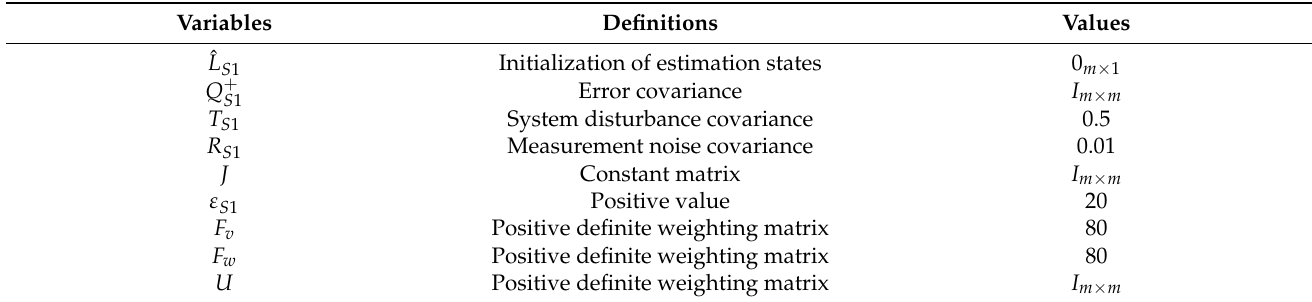
Table 4. Initial values of the proposed H 2 estimation design with respect to the tagged sound source